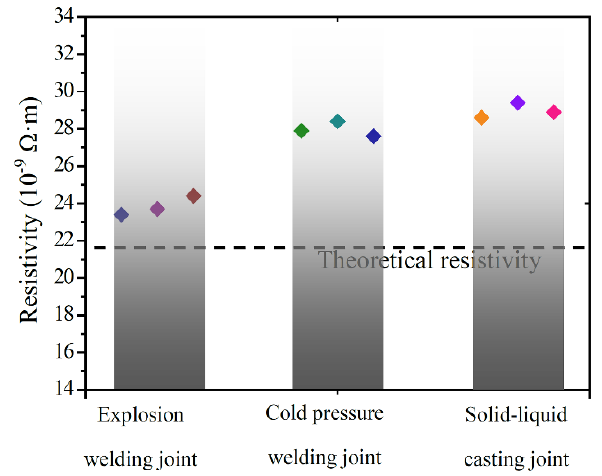
Figure 8. The resistivities of three types of Cu/Al joints.